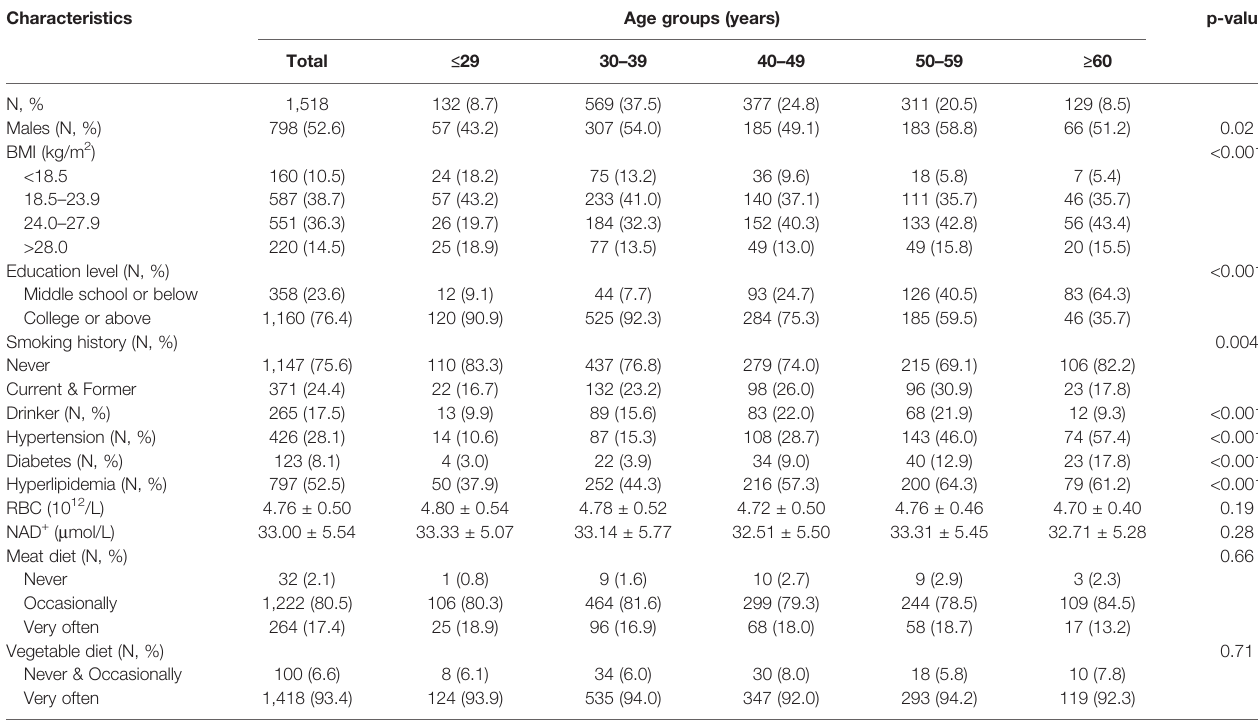
TABLE 1 | Baseline characteristics of the study population.